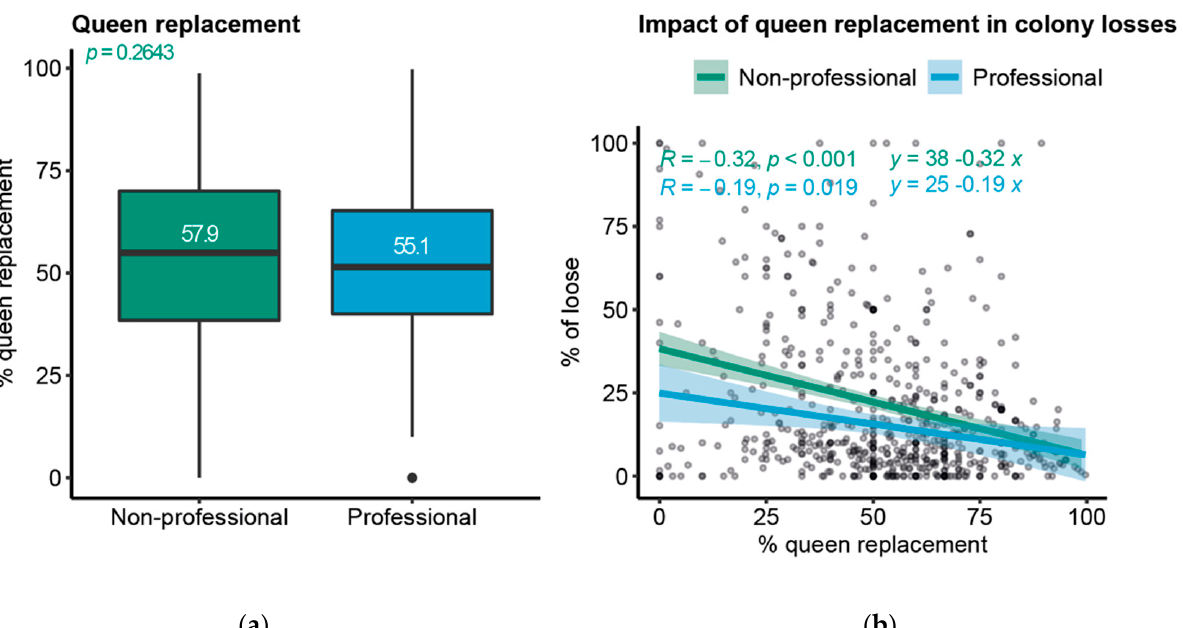
Figure 3. Queen replacements reduce colony losses: ( a ) box plot showing the % of queen replacement in relation to the beekeeper professional categories, p -value indicates the significance of unpaired two samples t -test; ( b ) scatter plot showing the relation between hive losses and queen replacement ( n = 618 beekeepers, p -values indicate the significance of Pearson’s correlation coefficient).